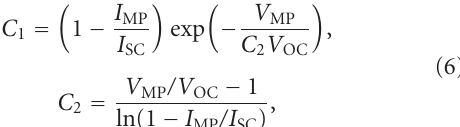
Figure 5: The solar radiation based on the reference